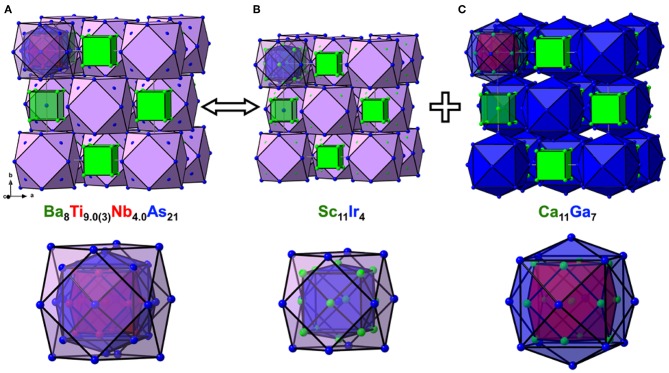
Crystal structures of Ba8Ti9.0(3)Nb4.0As21
(A), Sc11Ir4
(B), and Ca11Ga7
(C) in cluster representation, drawn at the same scale, along with the close-up view of the respective nested polyhedral clusters at the bottom. The shell structure of the nested and centered clusters is highlighted.